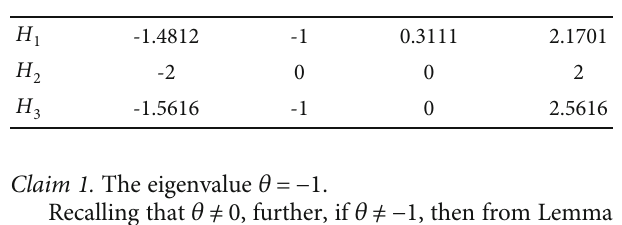
, H , and H 1 2 3 . 1 ≤ i ≤ 3 Þ i ð